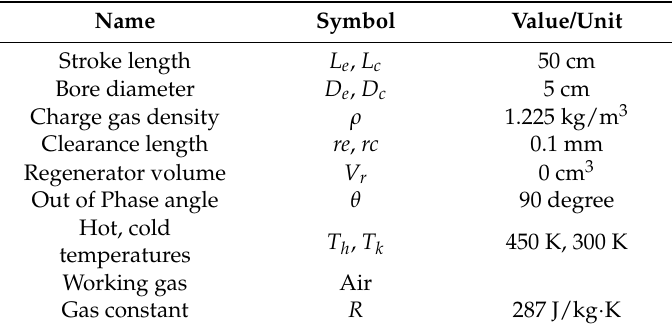
Table 1. Parameters of the reference